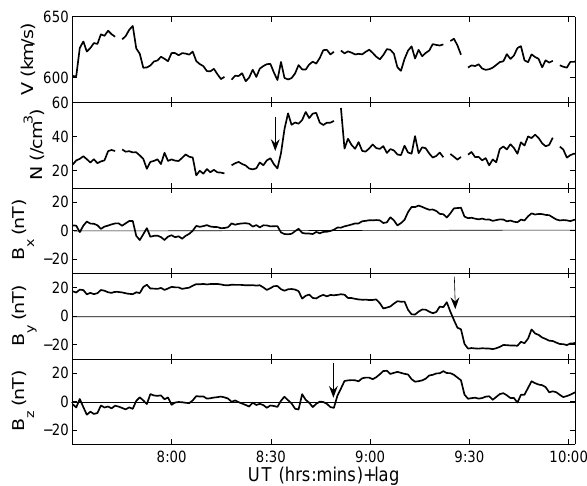
Fig. 7. Data from the ACE satellite for 27 November, 2000, lagged by 41min. Arrows mark the times of significant changes that result in observed effects in the ionosphere.